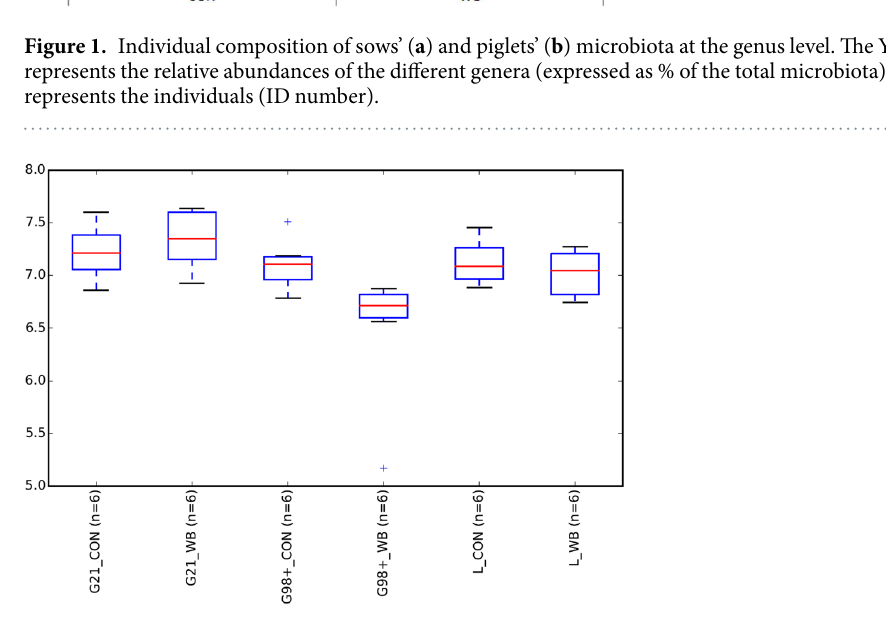
Figure 2. Distribution of alpha diversity as measured by Shannon index, box plots represent the calculated Shannon index for microbiota samples of sows fed the control diet (CON, N = 6) and the wheat bran-enriched diet (WB, N = 6) at three different stages: 21 d (G21) and 98 d (G98 + ) of gestation, respectively before and after the experimental diets were distributed, and 20 d of lactation